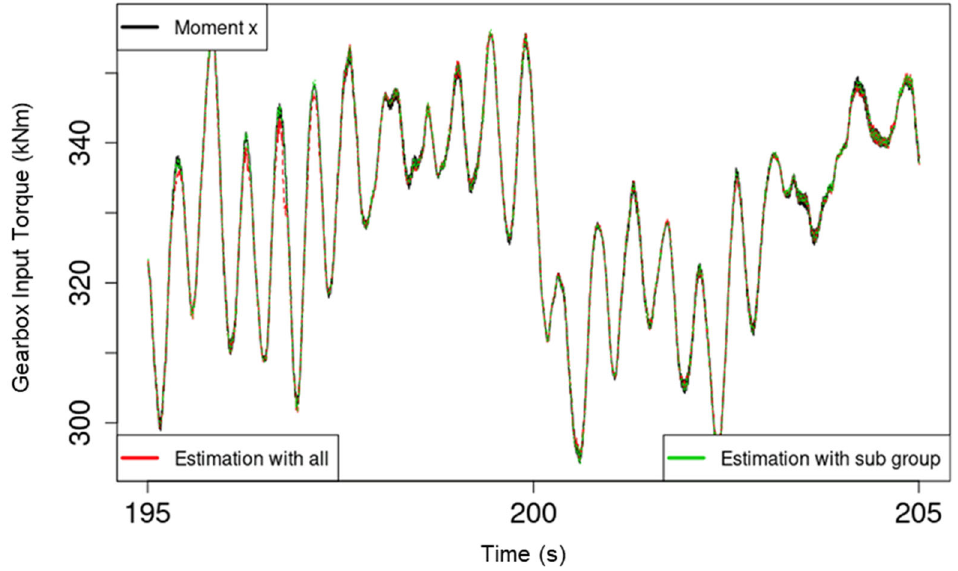
Figure 5. Plot of torque, model estimations with all predictors, and with only the highly important subset of predictors.